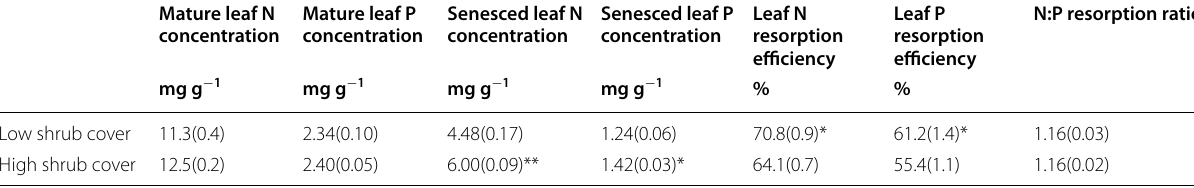
Data in the parentheses are the standard error of the mean values ( n